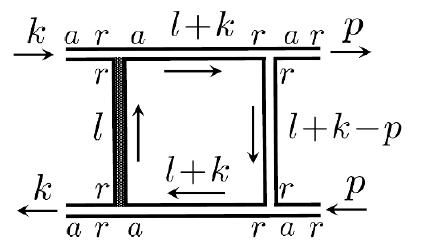
Figure 10 . The rung representing gluon splitting shown with the momentum convention and a and r